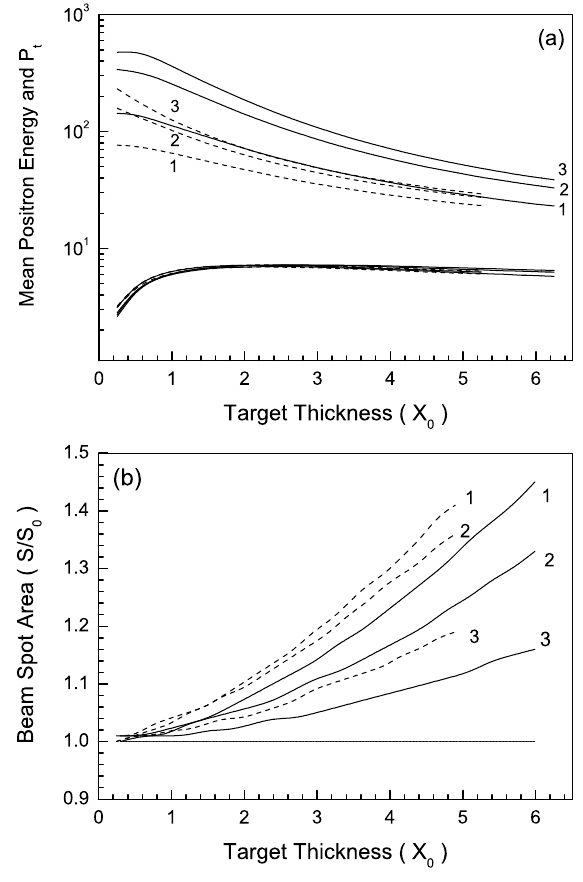
(cid:9) 2 GeV 0 0